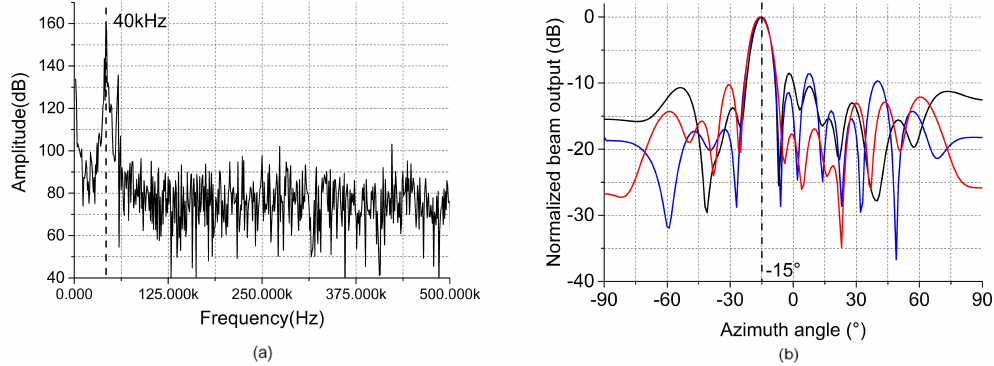
Figure 6. ( a ) The frequency spectrum of the leakage signal. ( b ) Localization results under identical experimental